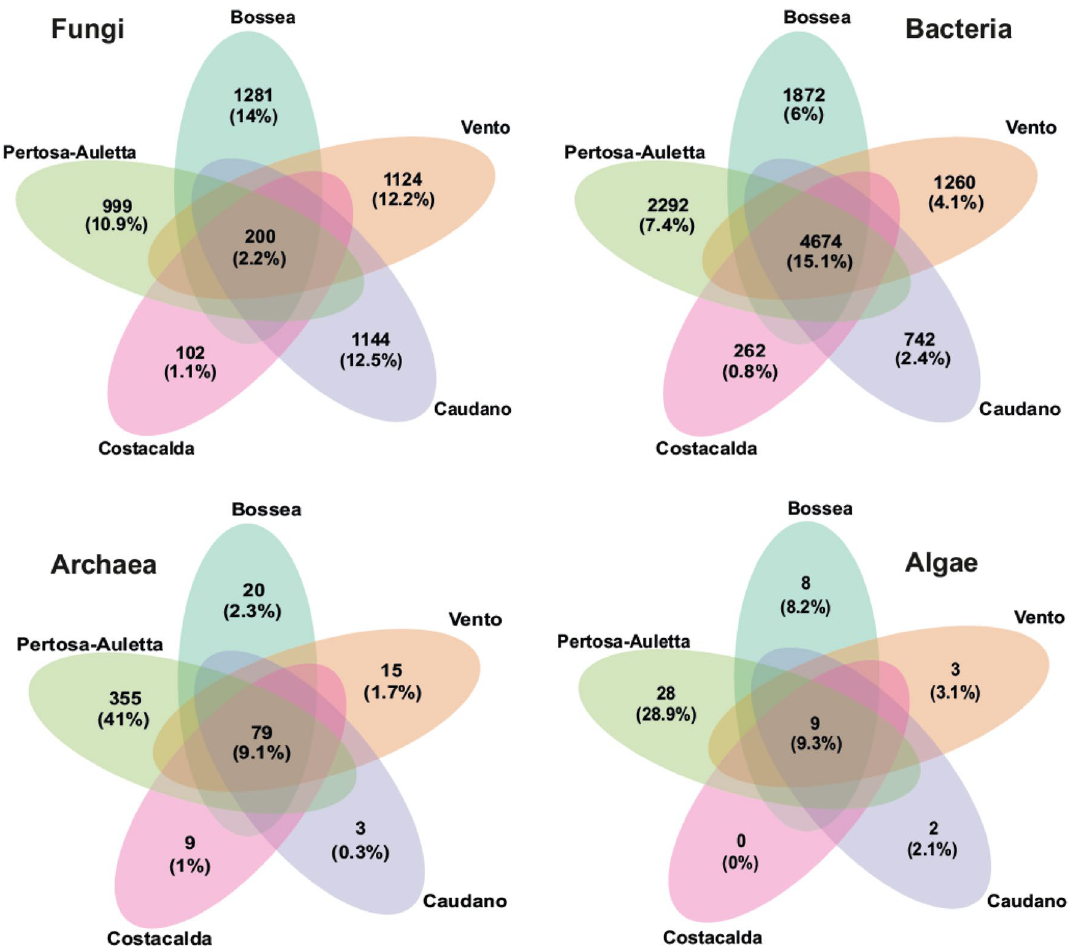
Vento (show -caves) and Costacalda (wild